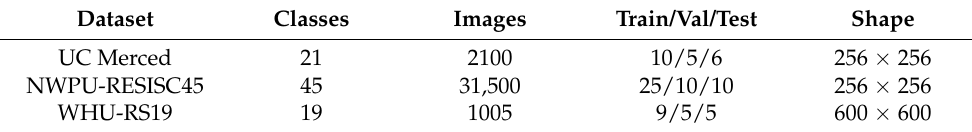
Table 1. Descriptions of UC Merced NWPU-RESISC45 and WHU-RS19.